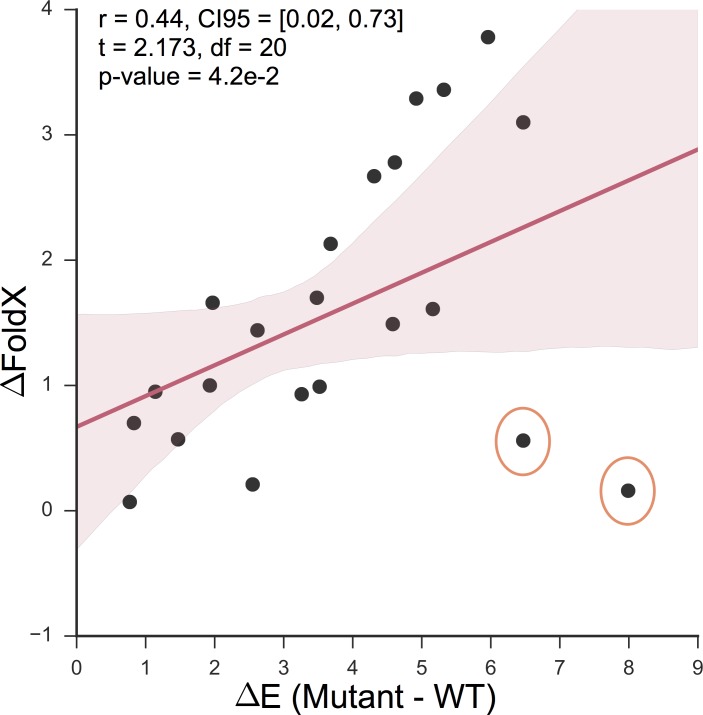
Evolutionary couplings-based model and FoldX prediction correlations.The red line is a fitted linear regression, and the red tube represents its 95-confidence interval. The orange-circled dots are the two mutational designs with the highest discrepancy. FoldX predicted these two mutations less deleterious compared maximum entropy model, although both designs introduced a mutation at a membrane-binding site.